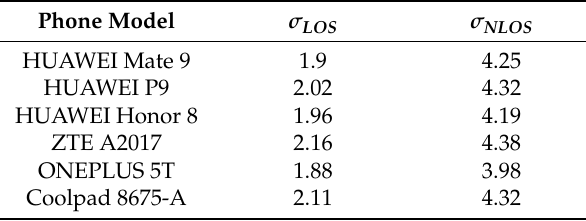
Table 2. The σ LOS and σ NLOS of different phone